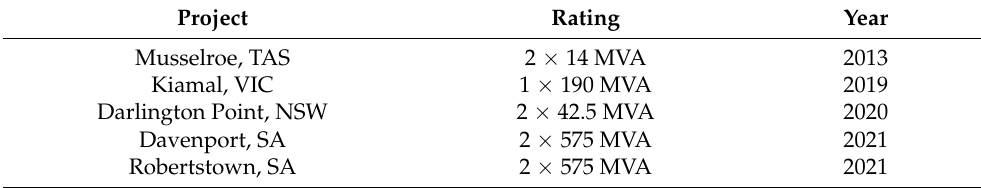
Table 2. Operational synchronous condensers in Australia [52,53].